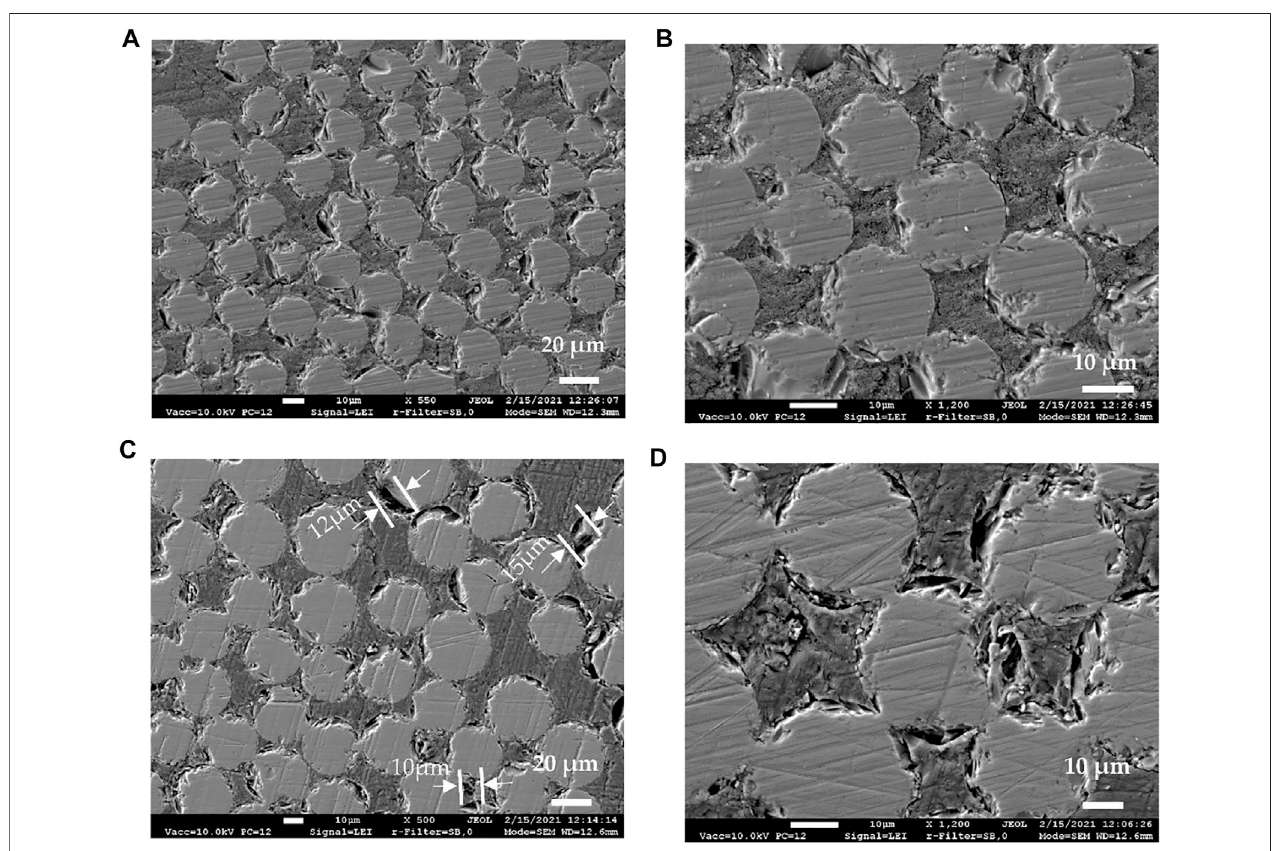
FIGURE 5 | SEM images of the web zones: (A , B) F IBERLINE pro fi le; (C , D) U GIRA sample.